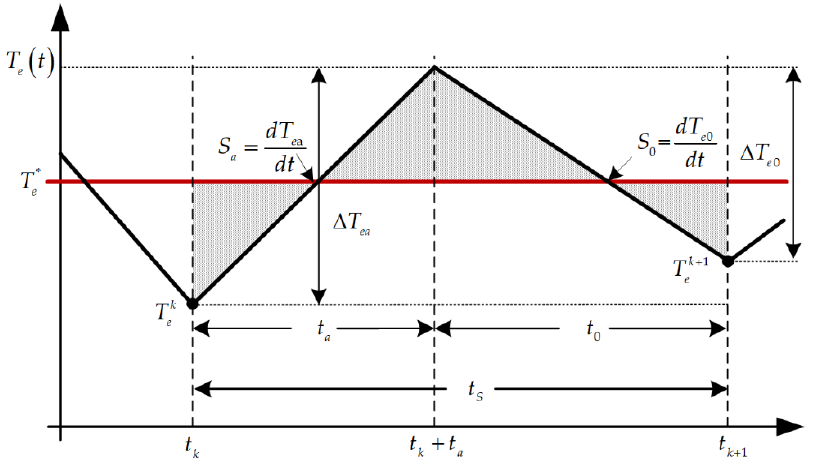
Figure 6. The torque ripple from the active voltage vector and the zero voltage vector. In Figure 6, T k is the torque at the beginning of the ( k + 1)th control period, T k + 1 e